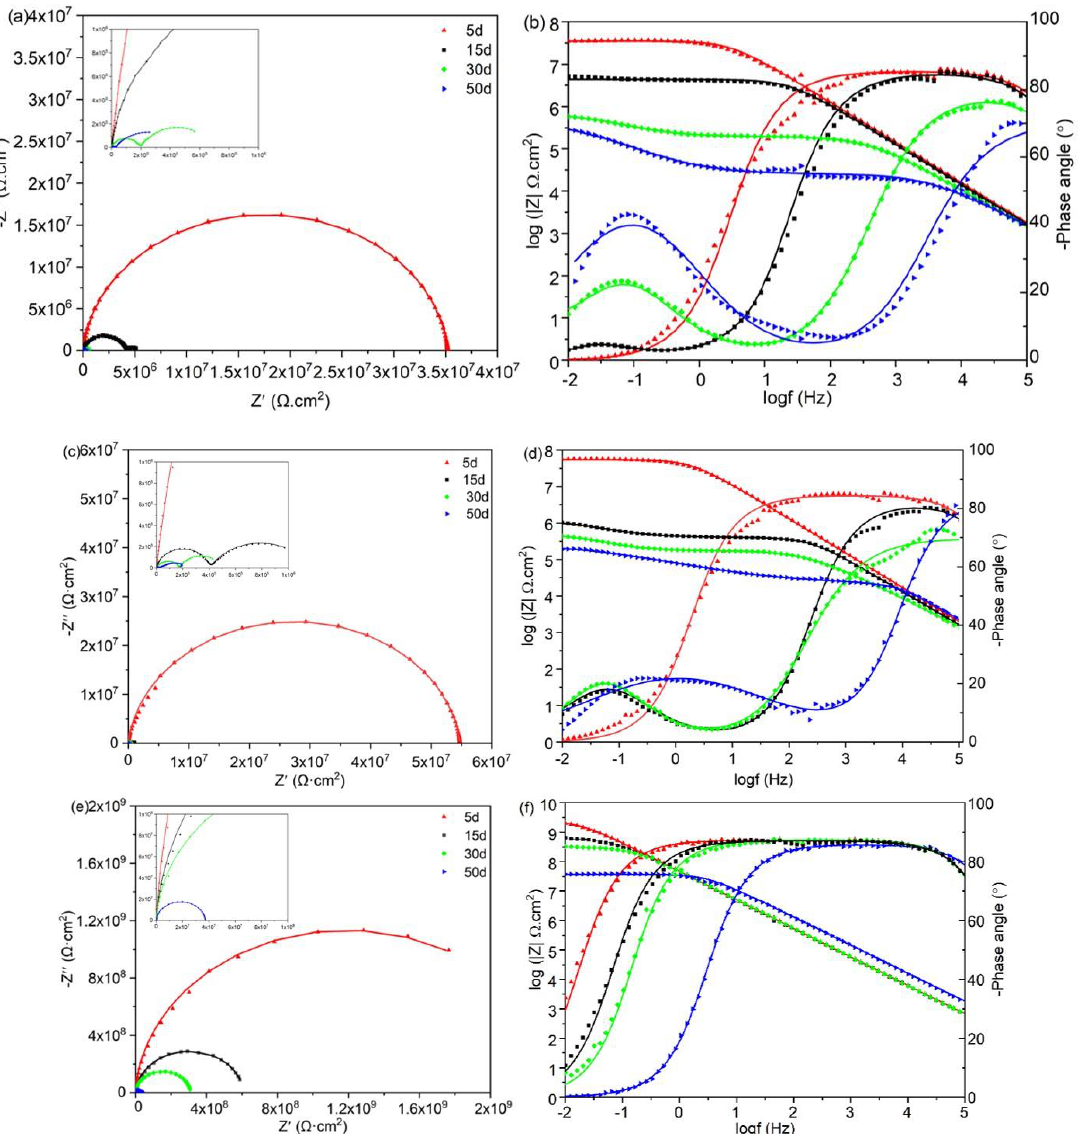
Figure 7. Nyquist and Bode plots of the neat WEP ( a , b ), MoS 2 /WEP ( c , d ) and MoS 2 -APTES/WEP ( e , f ) in a 3.5 wt.% NaCl solution.